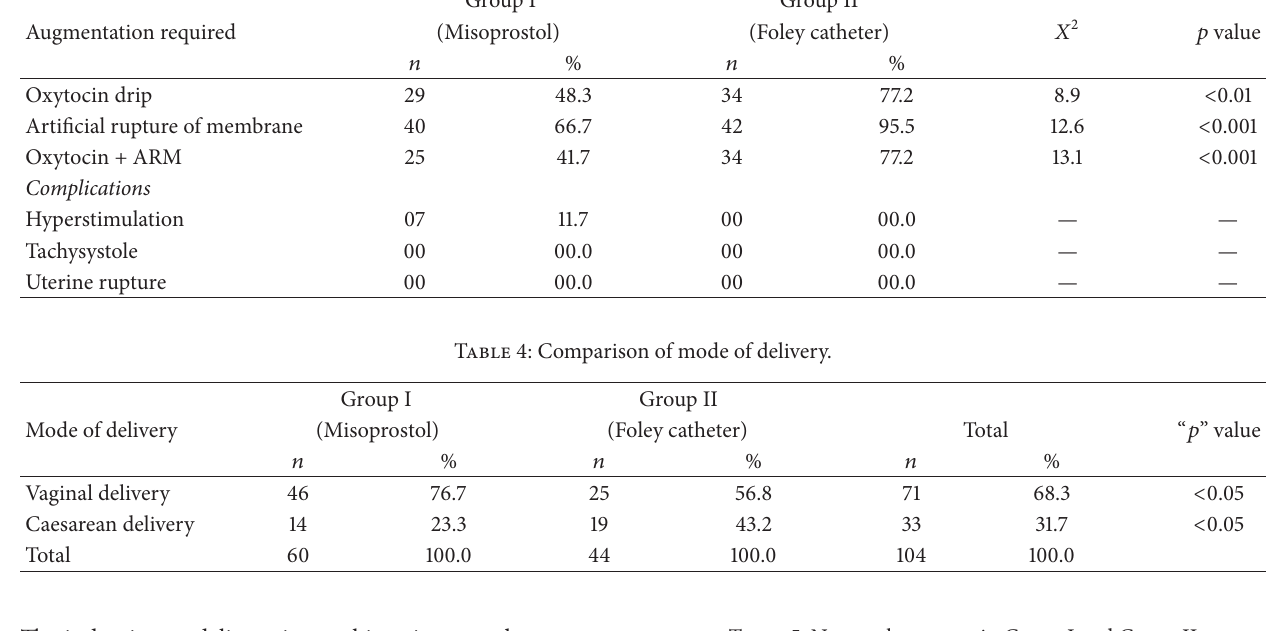
Table 5: Neonatal outcome in Group I and Group